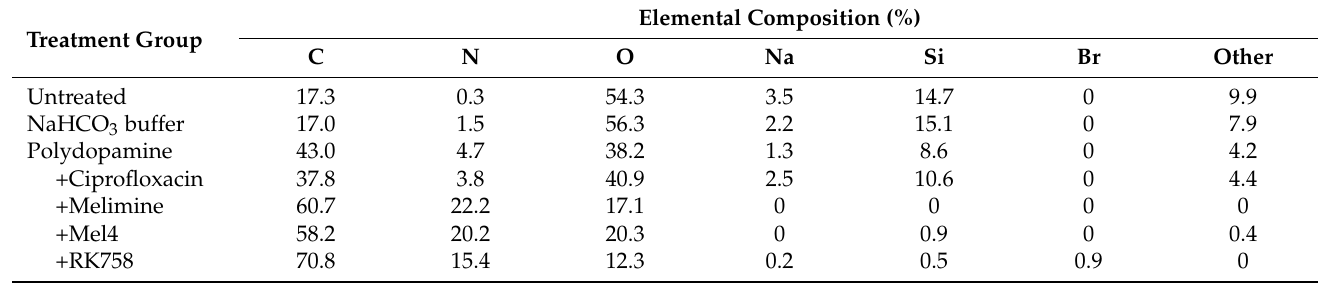
Table 1. Elemental composition (%) detected by X-ray photoelectron spectroscopy on glass surfaces. Treatment Group